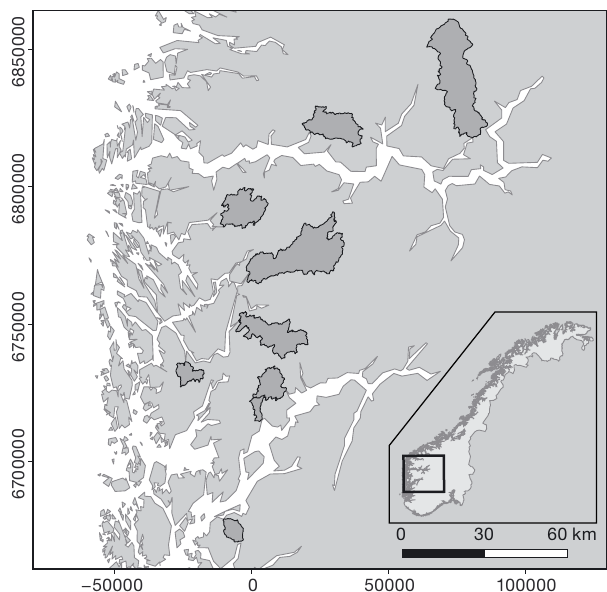
Fig. 1. Study area. Dark grey polygons: watersheds where comparison sampling occurred; black box: location in Norway (WGS84 / UTM zone